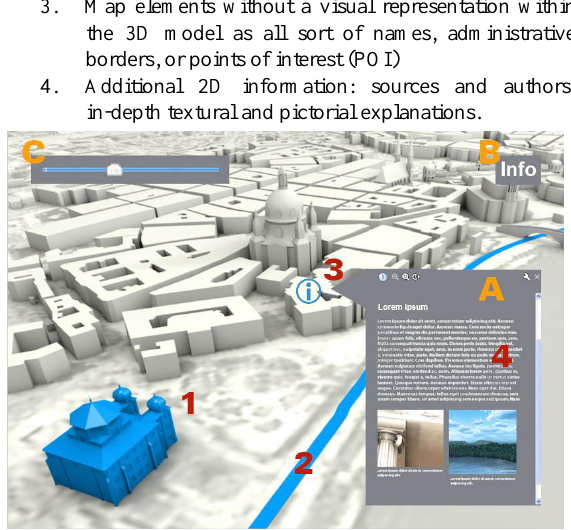
Figure 7: Information Classes and Instructional